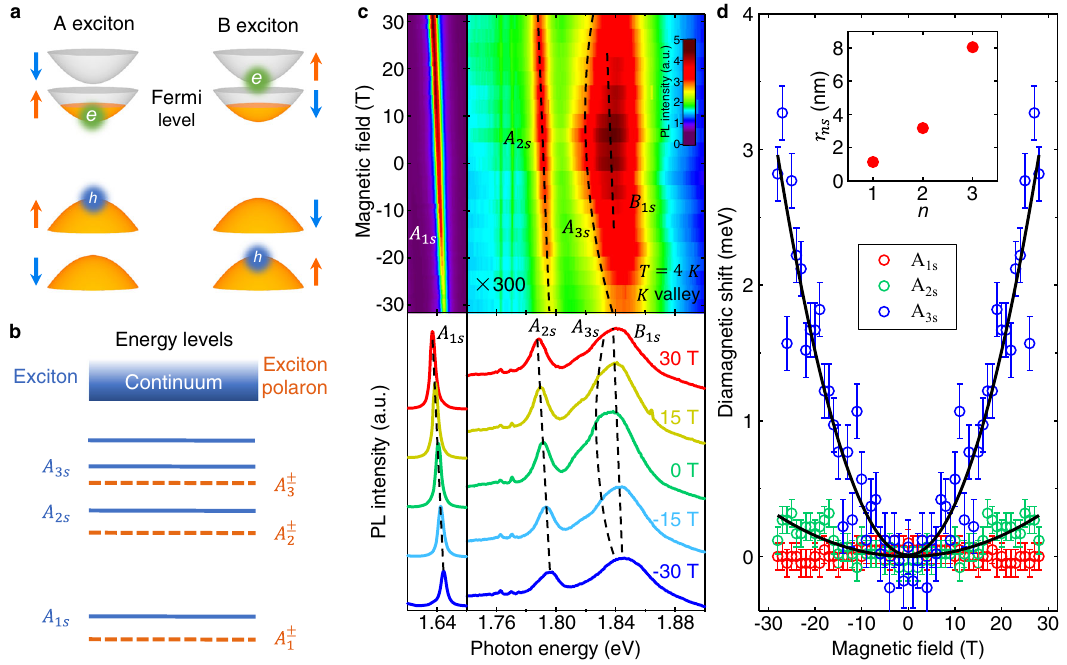
Fig. 2 Excitonic states in monolayer MoSe 2 . a The band con fi gurations of A and B bright excitons in monolayer MoSe 2 . The arrows denote the electron spin of the bands. The Fermi level reaches only the inner subbands in our experiment. b The internal energy levels of exciton and exciton polaron. c Magnetic- fi eld-dependent PL maps of monolayer MoSe 2 plotted in arbitrary unit (a.u.) at zero gate voltage and temperature T = 4 K. The lower panel shows the cross-cut PL spectra at fi ve different magnetic fi elds. The dashed lines highlight the exciton energy shifts. The PL intensity in 1.74 – 1.90 eV is magni fi ed 300 times for clarity. d The diamagnetic energy shift of the A -exciton 1s, 2s, and 3s states (denoted by red, green, and blue circles, respectively) as a function of the magnetic fi eld. The error bars represent the uncertainty in fi tting the PL spectra with multiple Lorentzian functions. The lines are quadratic fi ts. The inset shows the root-mean-square exciton radii ( r n s ) for the principal quantum number n = 1, 2, 3. r 2s and r 3s are extracted from the diamagnetic shifts. r is obtained by a theoretical model and it matches the experimental value in ref. 27 . 1s Photoluminescence